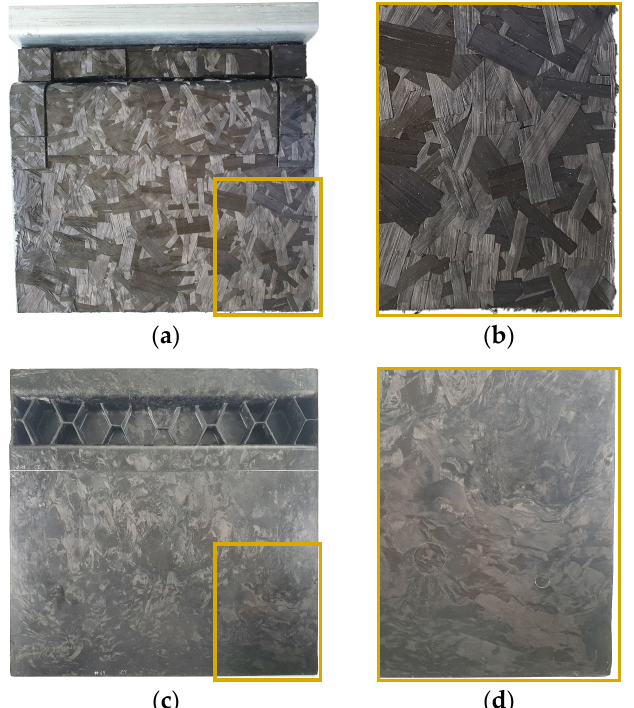
Figure 18. ( a ) Photo of the initial HexMC charge configuration with randomly oriented UD strands in several charge packages on a metal preform; ( b ) detailed view of the UD strands in the lower right corner of the base charge; ( c ) compression molded part; ( d ) detailed view of the lower right corner of the plate showing the flown and slightly deformed UD strands.